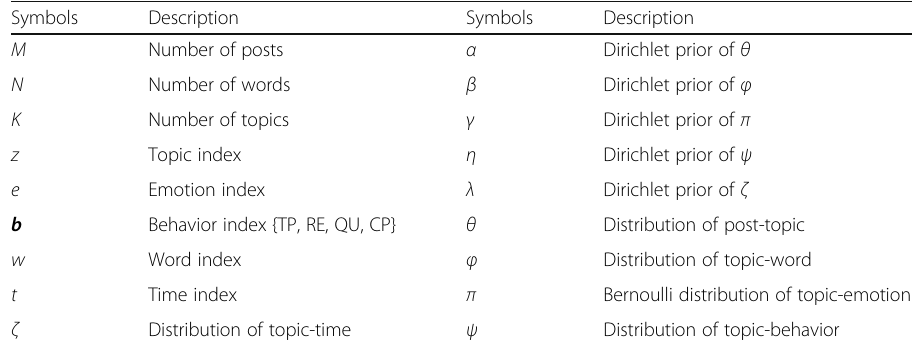
Table 2 Meaning of symbols used in TI-BETM Symbols Description Symbols